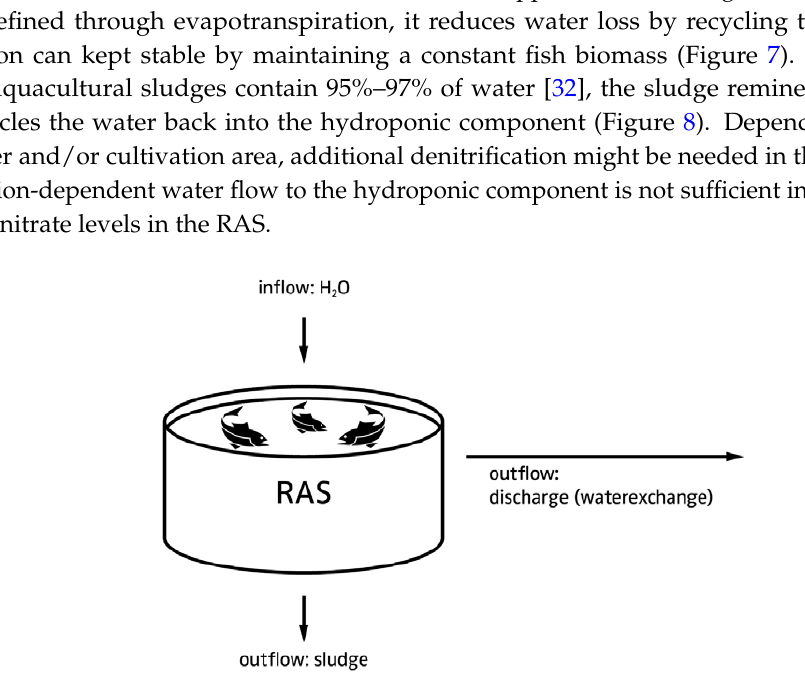
Figure 4. Water flow in a RAS system, whereas the tank represents the whole RAS system